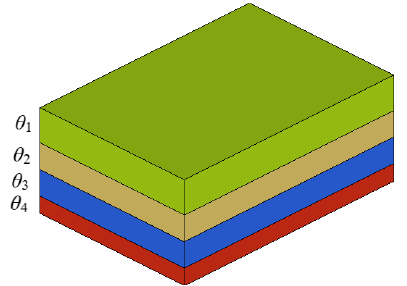
Figure 14. Schematic diagram of super layer.